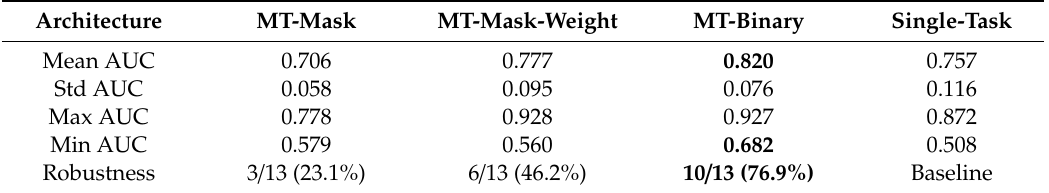
Table 5. Comparison of deep neural architectures for a similar target set (d ≤